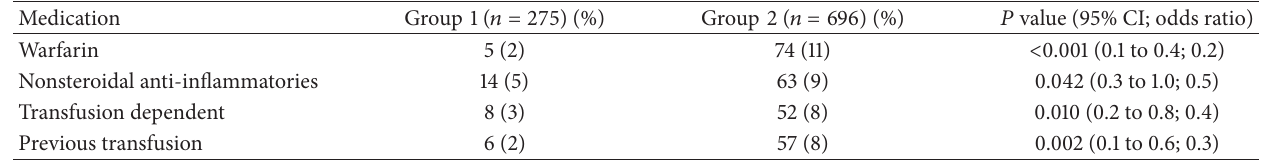
Table 2: Distribution of anticoagulation and transfusions in the < 50 and ≥ 50 years of age